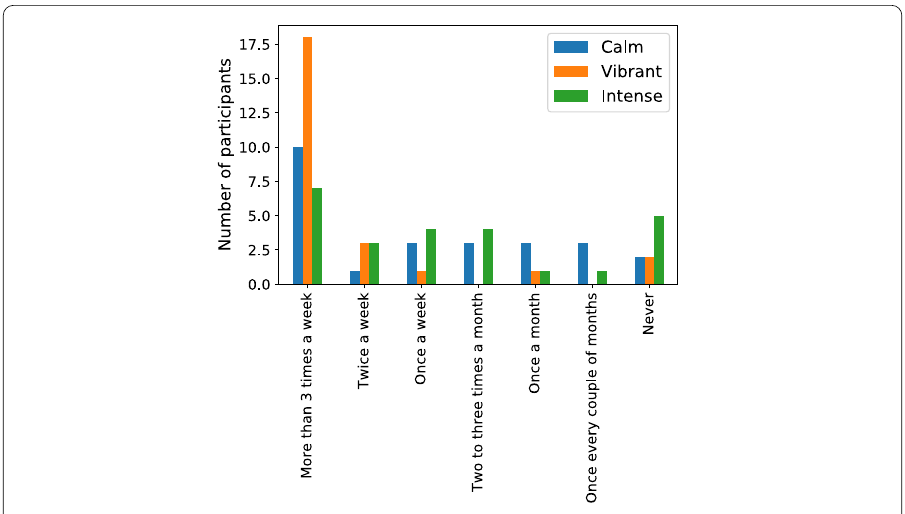
Figure 8 Participants’ frequency of listening to music for the three music archetypes. Twenty five participants participated in the study and rated how often they listen to music while engaged in the three music archetypes, namely calm (Blue), vibrant (Orange), and intense